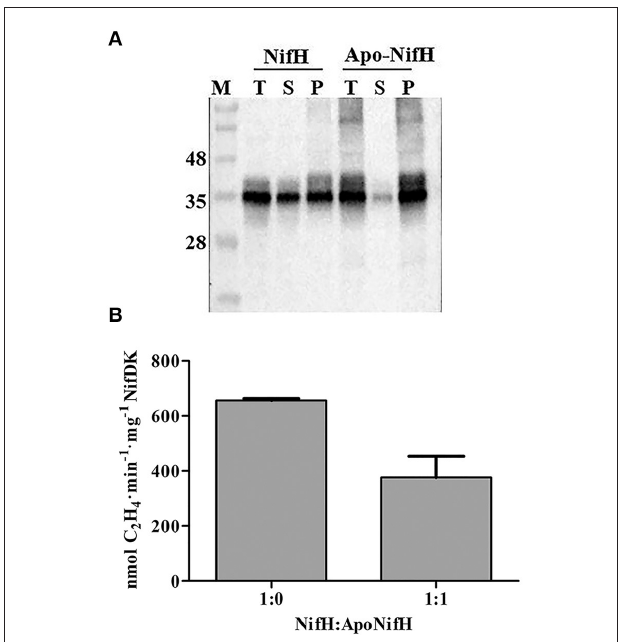
FIGURE 6 | Increased NifH specific activity correlates with apo-NifH precipitation after heat treatment. (A) Pure A. vinelandii apo-NifH or NifH (holo-NifH) were mixed with WT tobacco leaf extracts (T), heated at 55 ◦ C for 5min and then detected in soluble (S) or insoluble membrane-associated pellet (P) fractions by immunoblotting. (B) Pure NifH (8.2 µ g), or a 1:1 mixture of NifH (4.1 µ g) and apo-NifH (4.1 µ g), were mixed with WT tobacco leaf extract and used for ARA determinations. A 9:1 molar ratio of NifH:NifDK or NifH/apo-NifH:NifDK were used. Average activities ± SD ( n = 3) are shown.